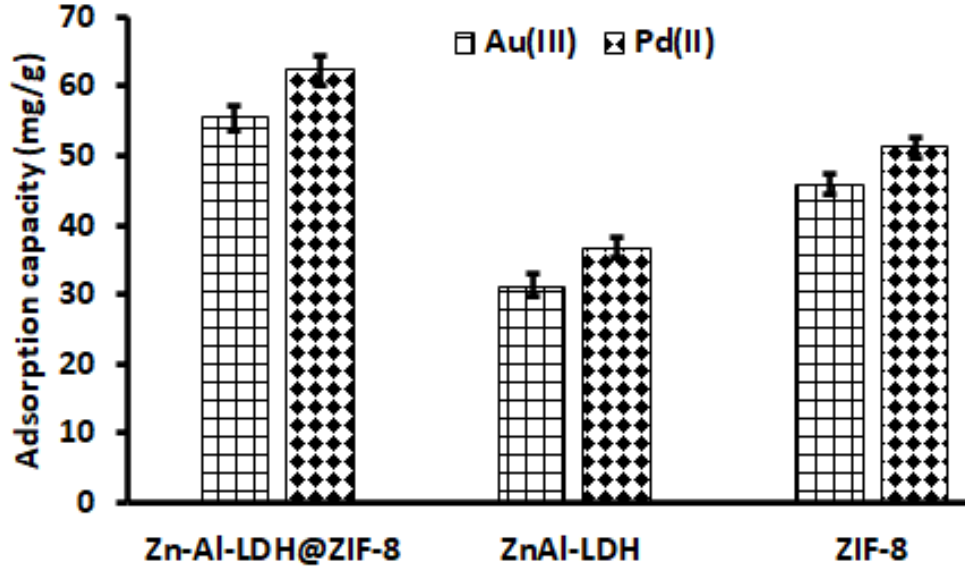
Figure 7. Selection of adsorbent. Experimental conditions: Mass of adsorbent, 100 mg; eluent con- centration, 2 mol L −1 ; initial concentration, 500 µg L −1 ; eluent volume, 10 mL; extraction time, 20 min; concentration, 2 mol L − 1 ; initial concentration, 500 µ g L − 1 ; eluent volume, 10 mL; extraction desorption time, 5 min; sample pH, 3.5; sample volume, 25 mL.